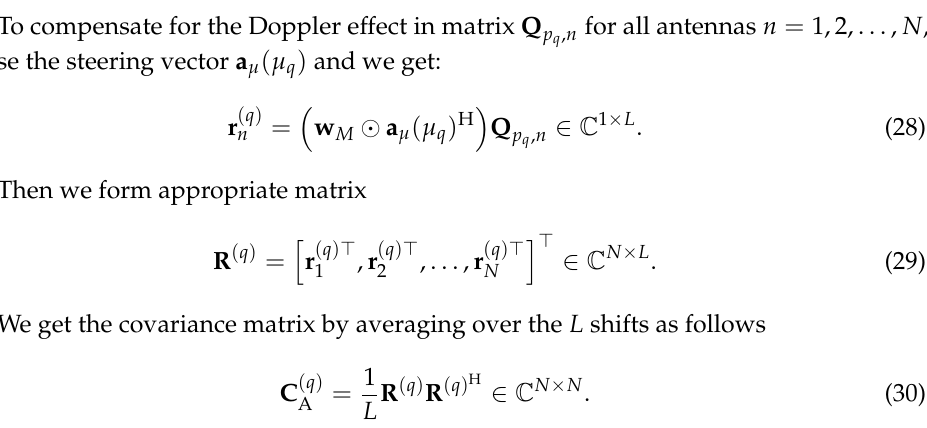
Figure 14. Finding of the appropriate column vector q and l =